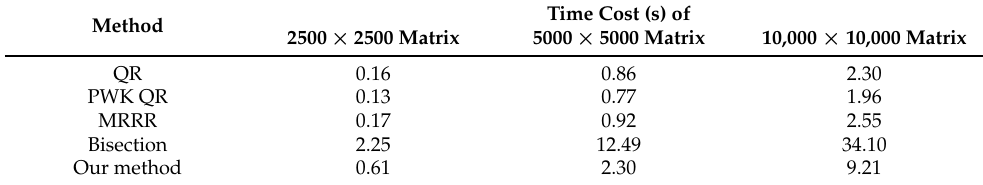
Table 3. Time Cost